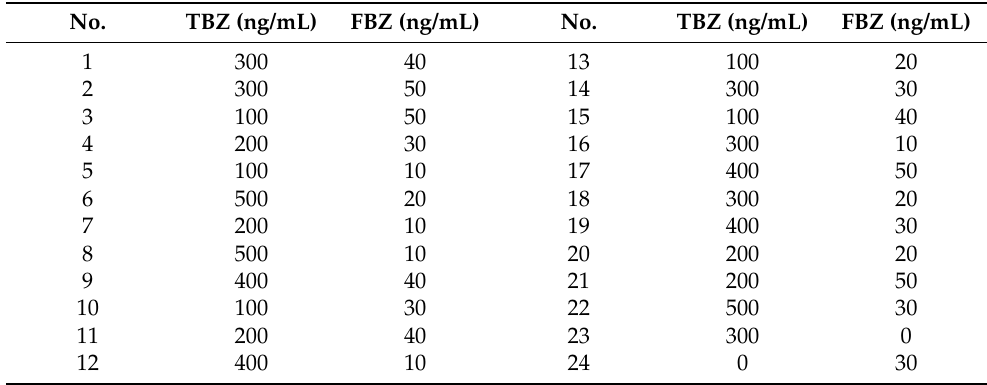
Table 1. Concentration of 24 calibration sets.